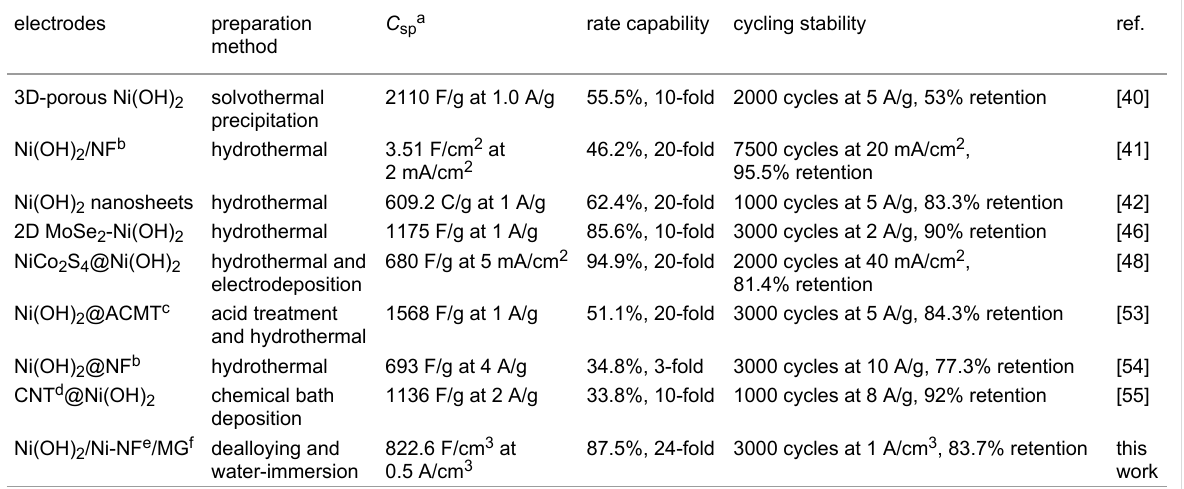
Table 1: Comparison of Ni(OH) 2 /Ni-NF/MG with other electrode materials.